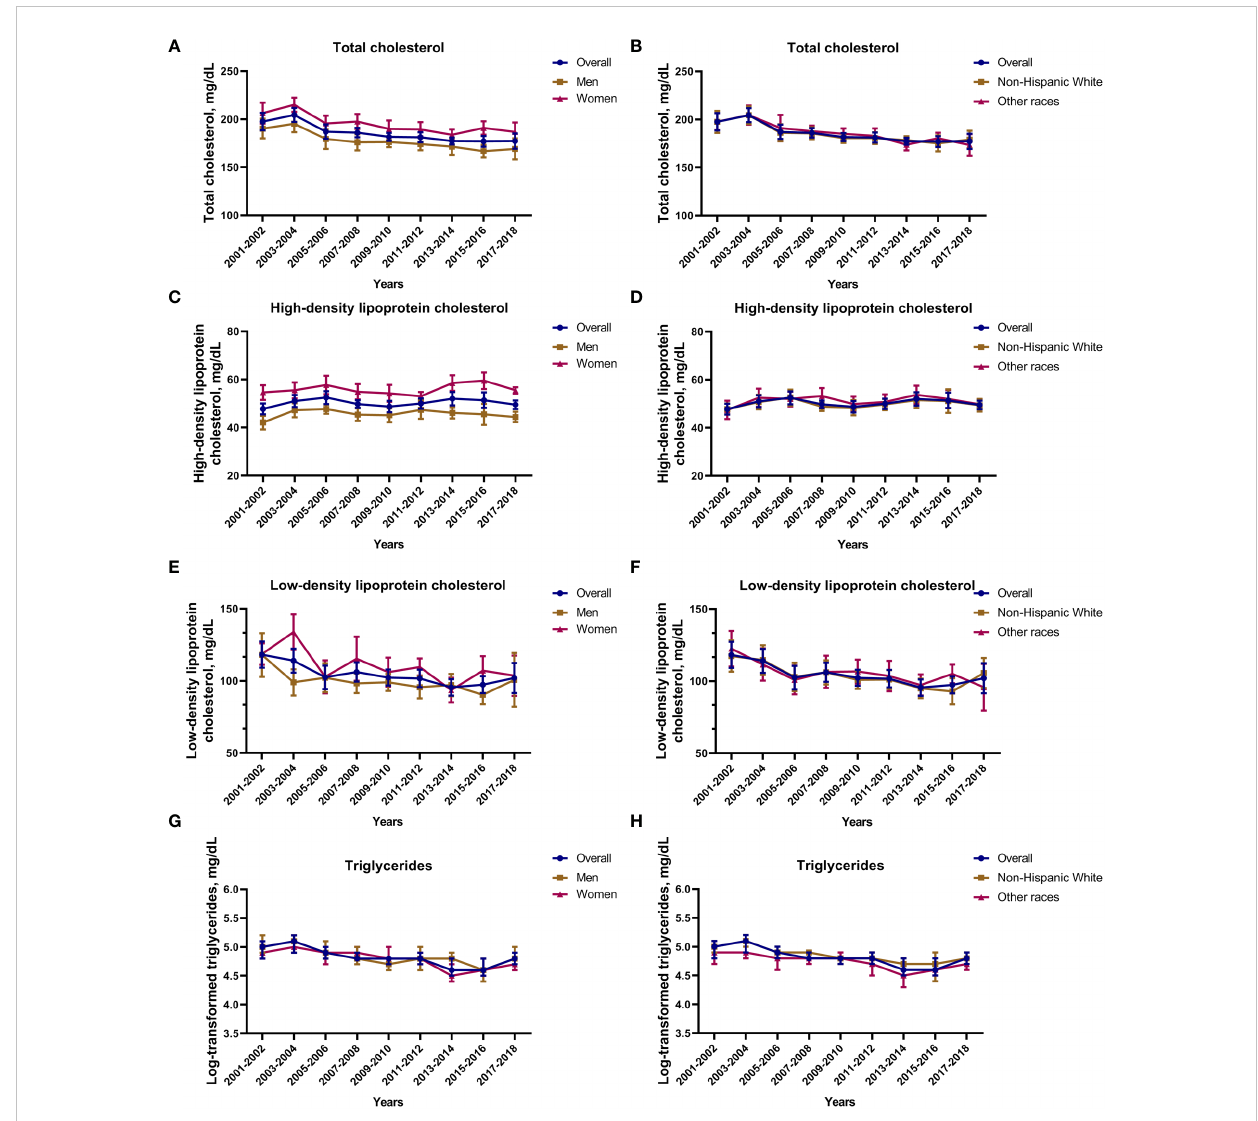
FIGURE 1 Total cholesterol, HDL, LDL and triglyceride concertation among survivors of stroke and/or myocardial infarction. (A) Total cholesterol concentration based on sex; (B) total cholesterol concentration based on race; (C) HDD concentration based on sex; (D) HDD concentration based on race; (E) LDD concentration based on sex; (F) LDD concentration based on race; (G) log-transformed triglyceride concentration based on sex; (H) log- transformed triglyceride concentration based on race. Nationally representative estimates of the survivors of stroke and/or myocardial